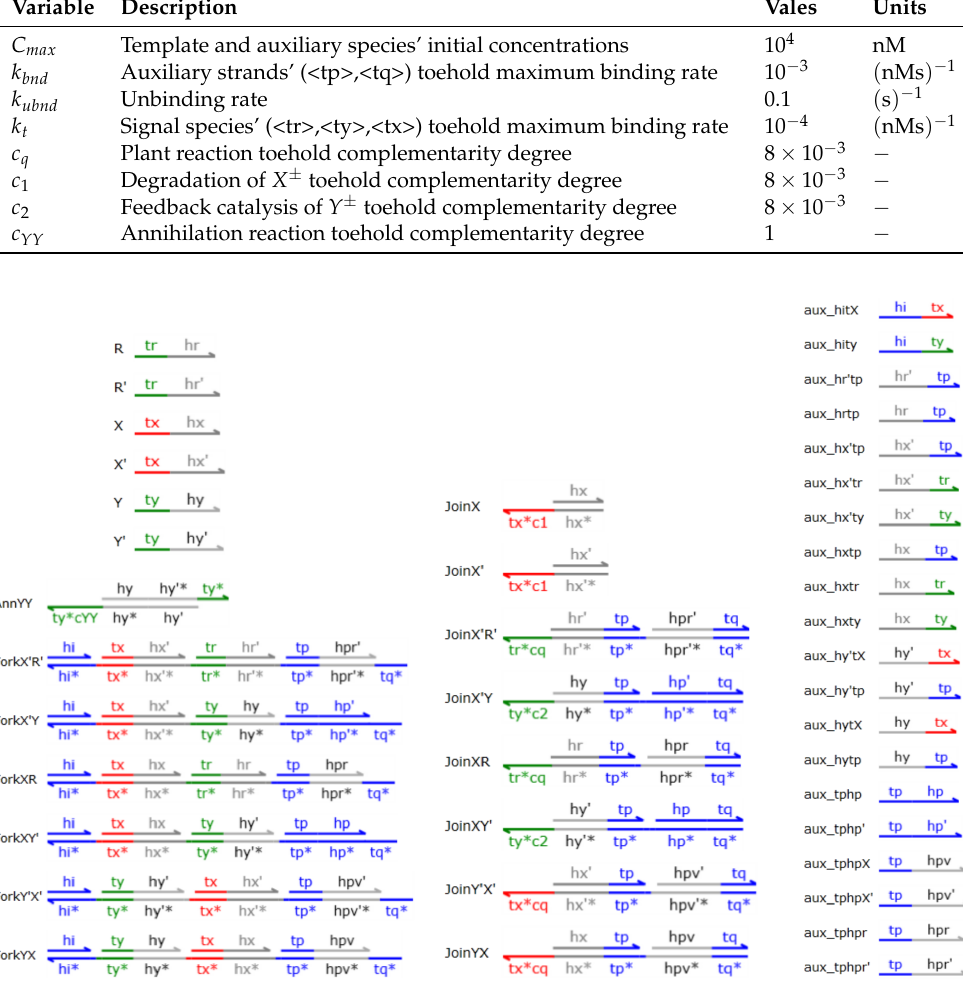
Figure 15. Set of toehold-mediated species present initially for the DSD network representation of the state feedback control of the double-integrator. The strands R, R (cid:48) , X, X (cid:48) , and Y, Y (cid:48) are the dual-species for the signals. Together with the auxiliary strands, they were initialised at high